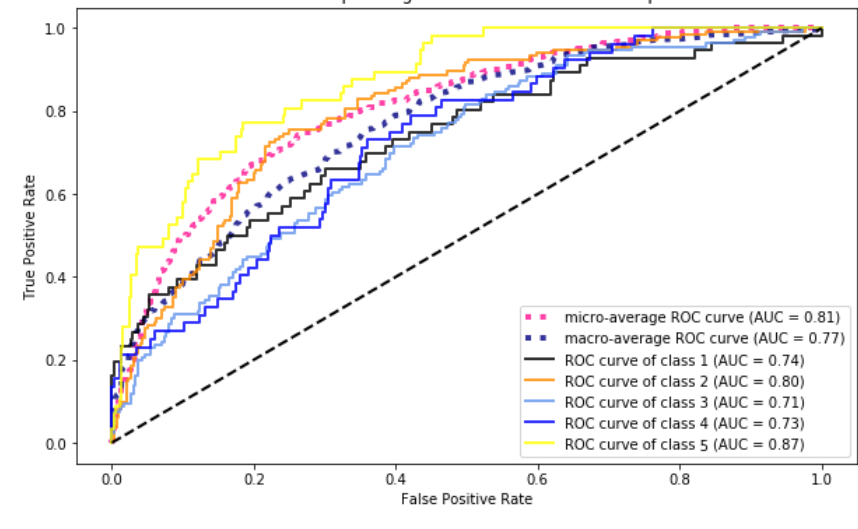
Figure 7. ROC curves for each class of train